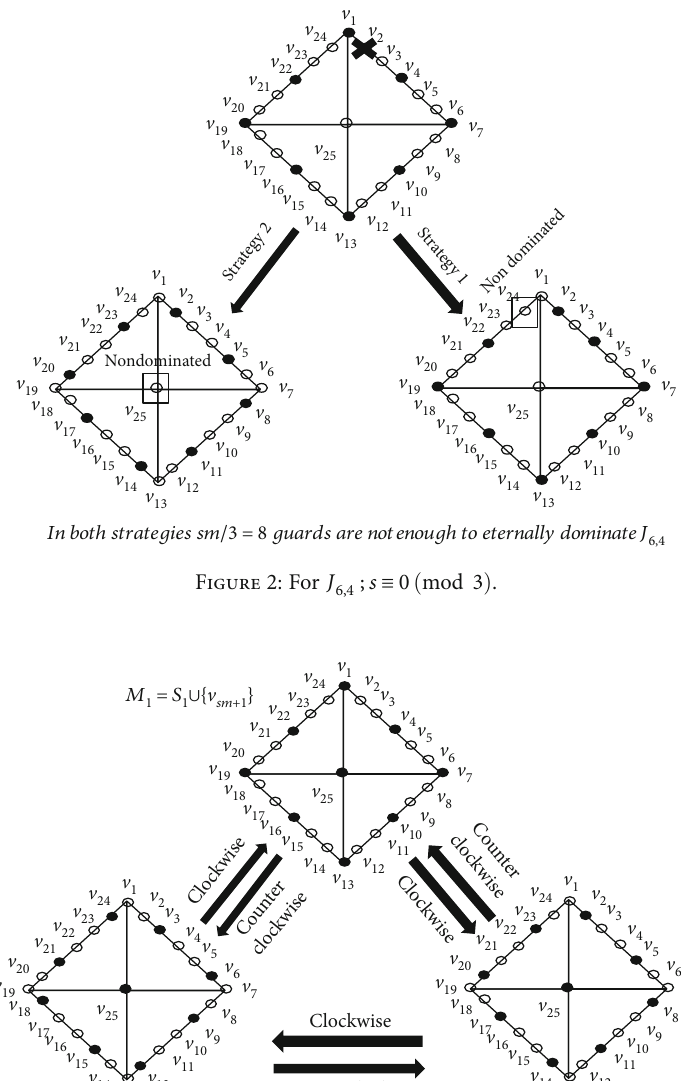
; s ≡ 0 ð mod 3 Þ 6,4